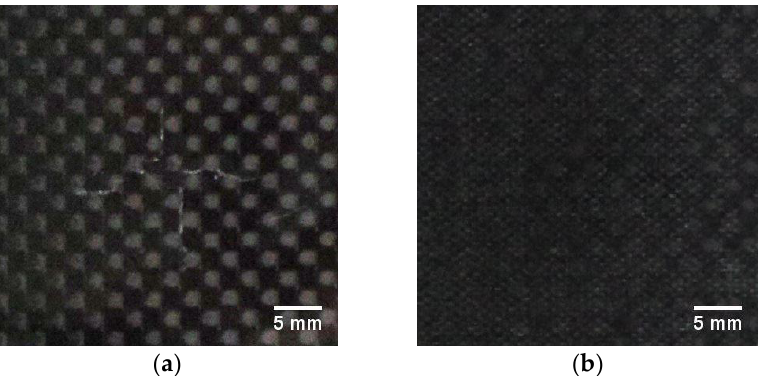
Figure 2. Experimental setup for the introduction of BVID.